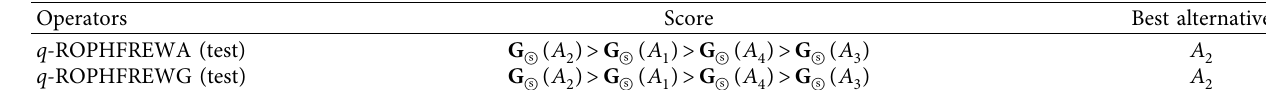
Table 14: Ranking of the